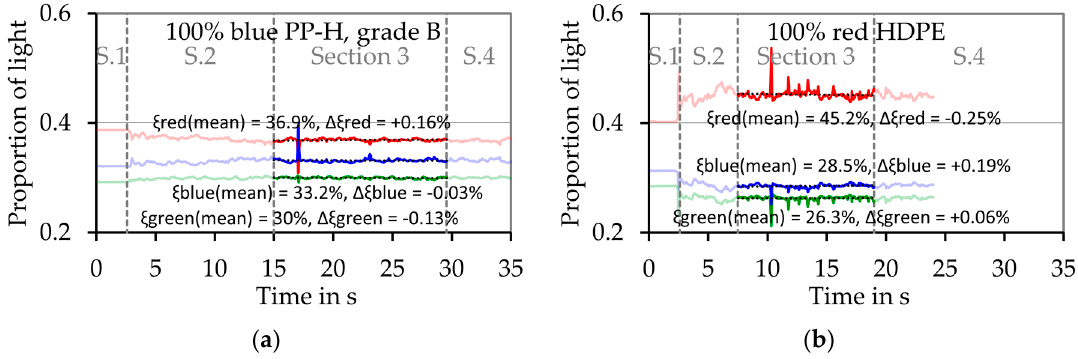
Figure15. Resultsoftheopticalevaluationofthemeltingexperimentfortwopurepolymers. Thedashed line shows the transitions between the four sections. ( a ) Pure blue PP-H; ( b ) pure red